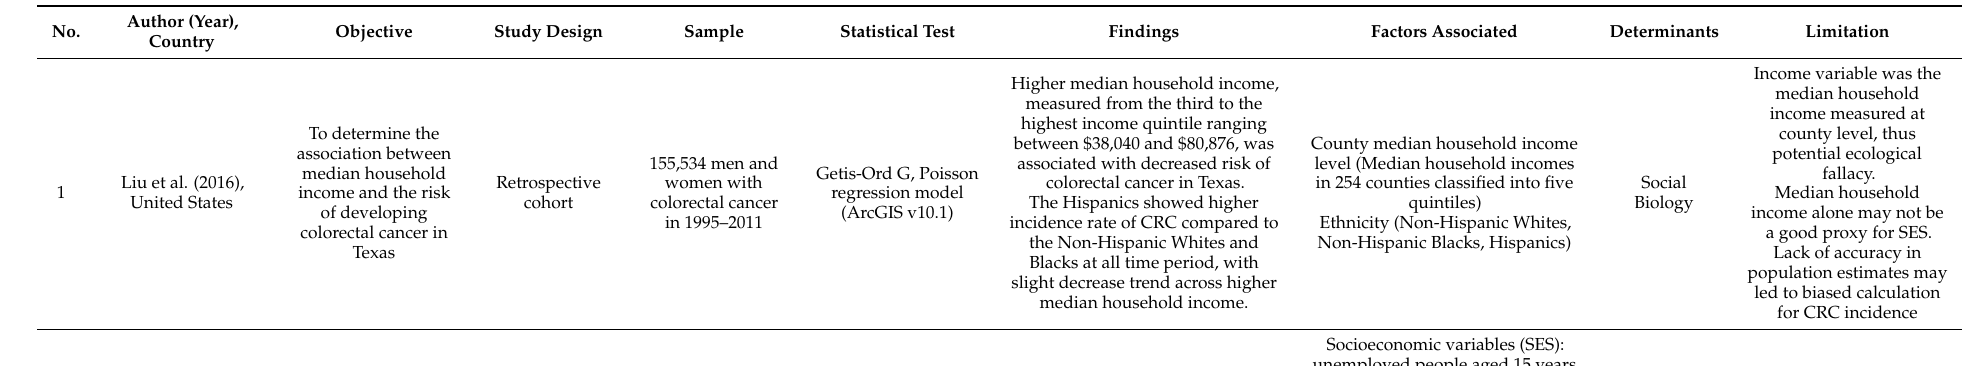
Table 3. Characteristics of included